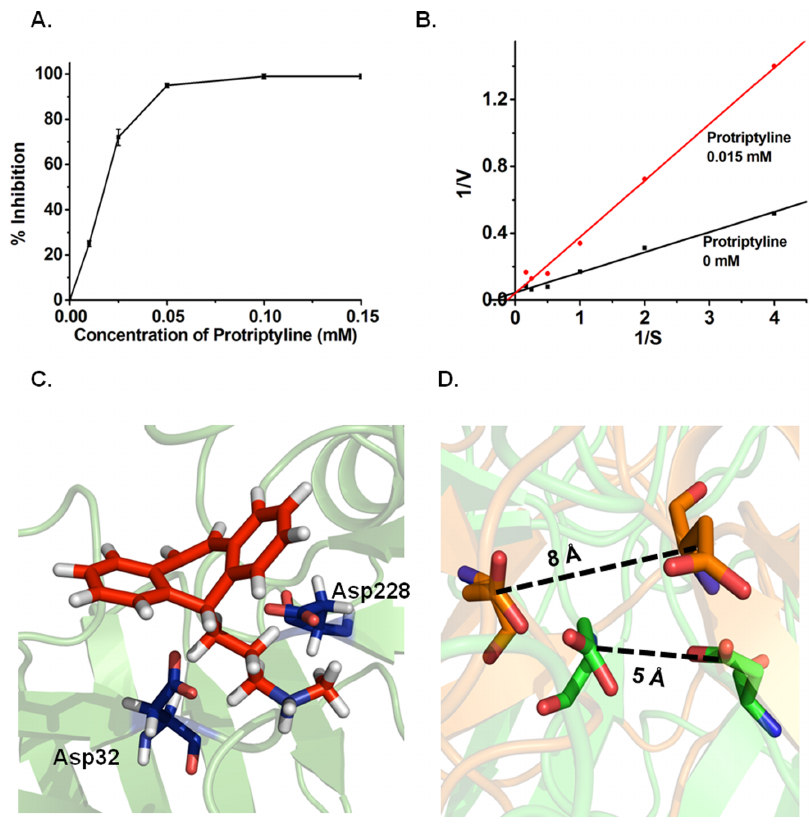
Figure 5. BACE-1 inhibition by protriptyline. A . Determination of IC50 of BACE-1 by using various concentrations of protriptyline. The sigmoidal curve indicates the best fit for the percentage inhibition data obtained B . Lineweaver-Burk analysis to estimate the kinetic constants. It showed competitive inhibition. C . Snapshot of drug binding with active site of BACE-1. Active site residues in BACE-1 are in line representation. D . Active site of BACE-1. The structures from unbound (green) and ligand bound (orange) simulations are shown after all - atom superimposition. Snapshots are generated using PyMol.